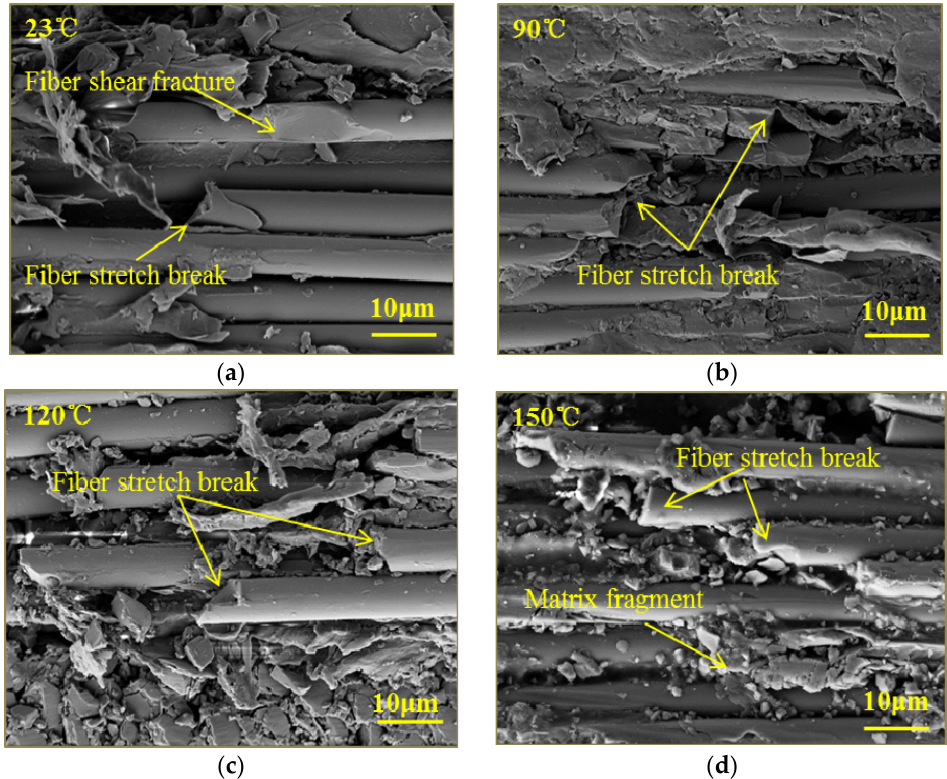
Figure 10. SEM micrographs of GF/PPS specimen under strain rate of 1450/s at different temperatures: ( a ) 23 ◦ C; ( b ) 90 ◦ C; ( c ) 120 ◦ C; ( d ) 150 ◦ C.